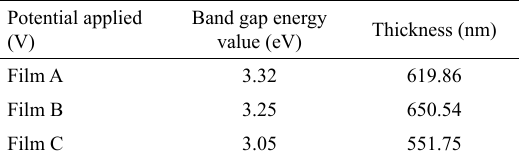
Figure 6. Extrapolation of the Tauc plots to determine bang gap values Table 1. Band gap values and film thickness.